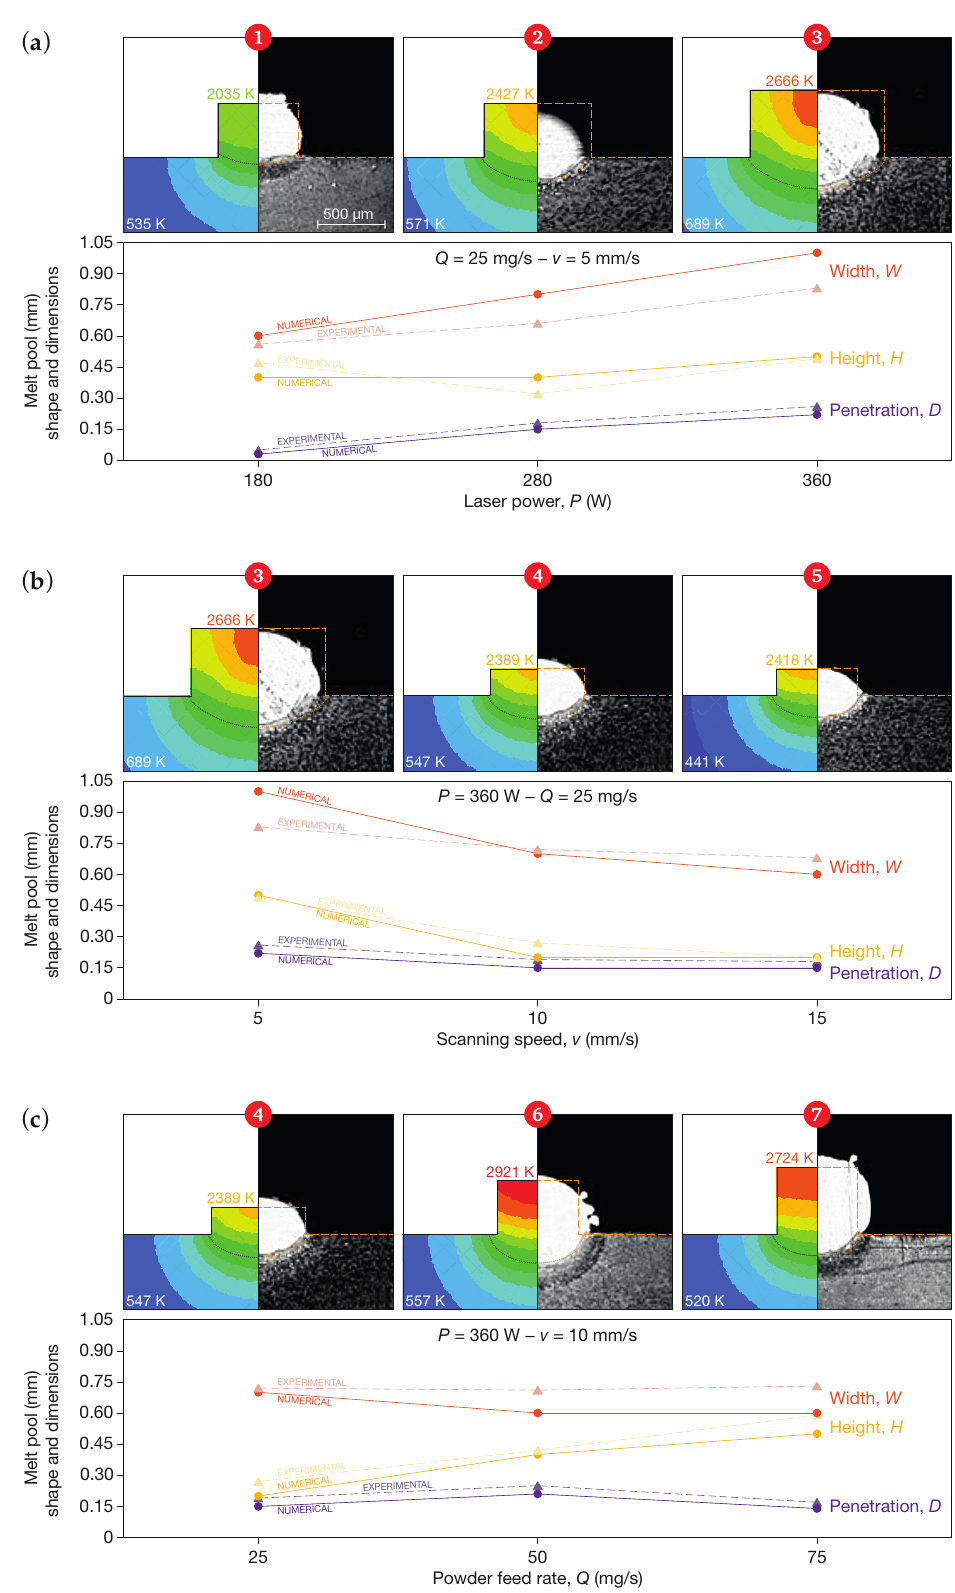
Figure 8. Temperature distributions and melt pool dimensions: comparison of the numerical results with experimental data as a function of ( a ) laser power, ( b ) scanning speed, and ( c ) powder feed rate. The temperature legend is the same as that of Figure 7, and for each set, the maximum and minimum temperatures are shown. The dotted line represents the melt pool